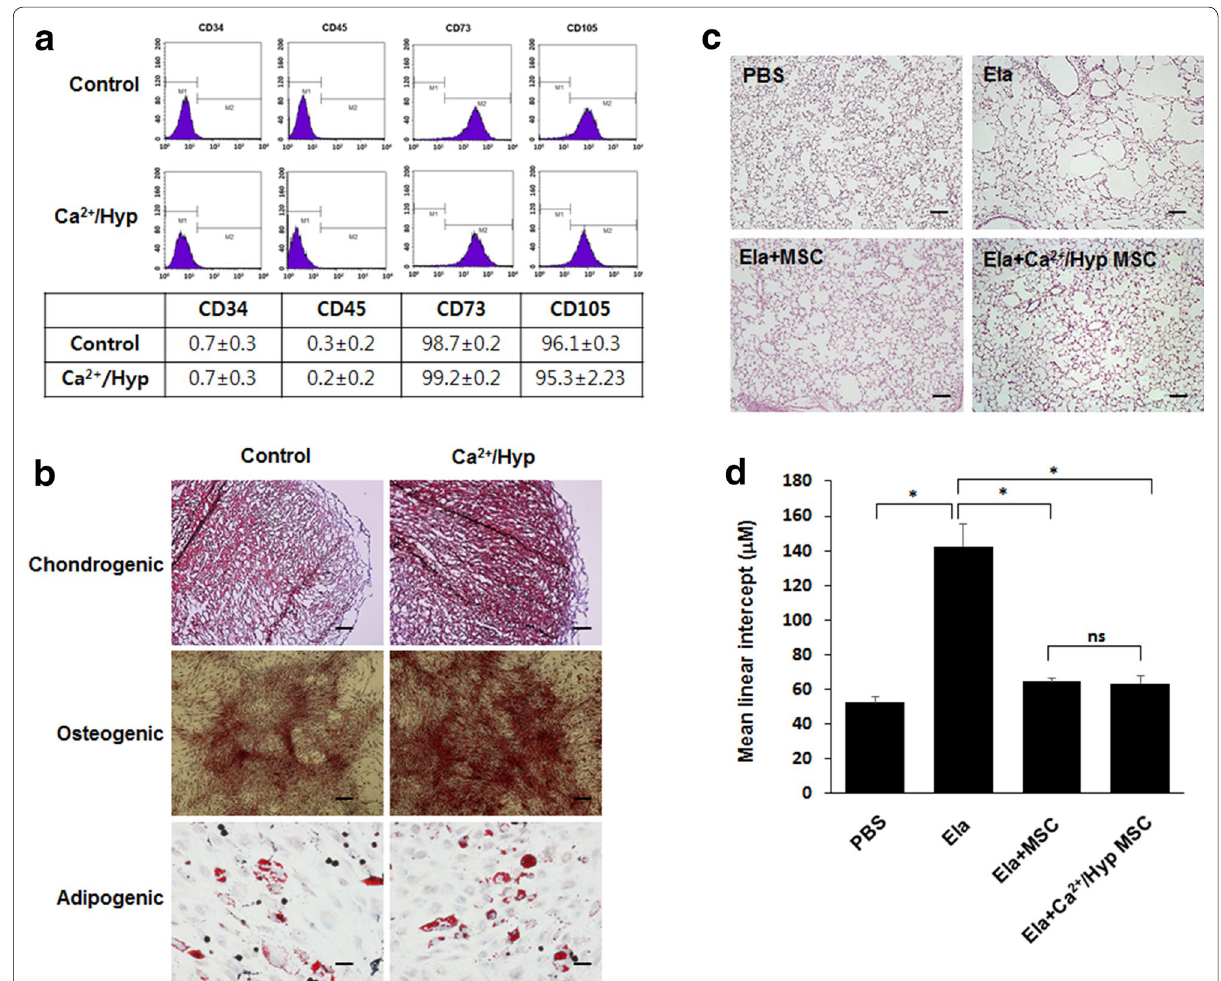
Fig. 6 Effects of Ca 2 + /hypoxia on the stem cell phenotypes of hUCB‑MSCs. a Immunophenotypic analysis of CD34, CD45, CD73, and CD105 expres‑ sion in naïve or Ca 2 + /hypoxia‑conditioned hUCB‑MSCs was performed using flow cytometry. b After incubation in specialized induction media, chondrogenic differentiation was measured by the accumulation of sulfated proteoglycan using safranin O staining (top), and osteogenic differen‑ tiation was evaluated by alkaline phosphatase staining (bottom). Data represent the mean SD (n 3). * P < 0.05 versus the control as determined ± = by Student’s t‑tests. c The therapeutic effects of hUCB‑MSCs in an elastase‑induced emphysema model. Representative histological image of the lung parenchyma stained with hematoxylin‑eosin (H&E). d Morphometric analysis of the mean linear intercept. Data represent the mean SD, ± n 3; * P < 0.0001. Scale bar 100 μm (magnification: 100 = = ×